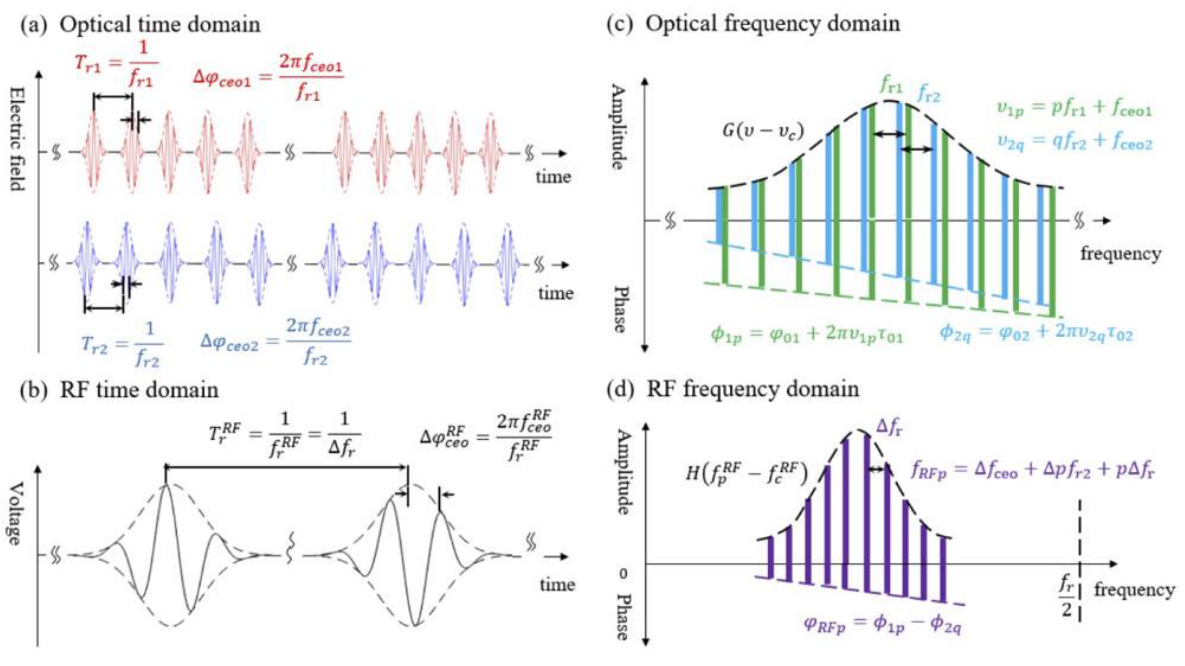
Figure 1. Principle of dual-comb interference [22]. ( a ) Time domain of the two combs’ periodic sequence; ( b ) time domain of the interference envelope diagram in the RF; ( c ) OF domains of the LO and SIG combs; ( d ) RF spectrum of SIG.